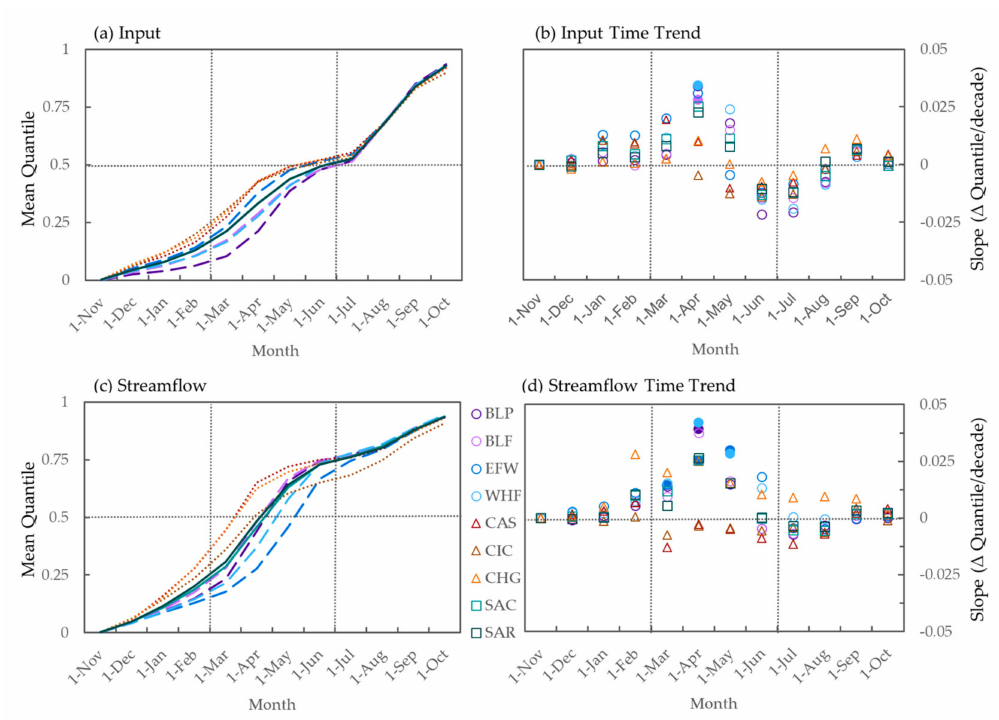
Figure 6. Mean monthly quantiles for hydrological inputs (sum of snowmelt, rain-on-snow, rainfall) ( a ) and streamflow ( c ) in Salt River basins from 1968–2011, and decadal trends in input quantiles ( b ) and streamflow quantiles ( d ) using Mann-Kendall test [42,43] and Sen’s slope estimator [45]. Temporal trends were significant ( p < 0.05) for filled symbols. Positive slopes indicate a trend toward a higher amount of annual total input or streamflow for the given date. BLP, BLF, EFW, WHF sub-basins in White Mountains; CAS, CIC, CHG in Mogollon Rim; SAC, SAR in Salt